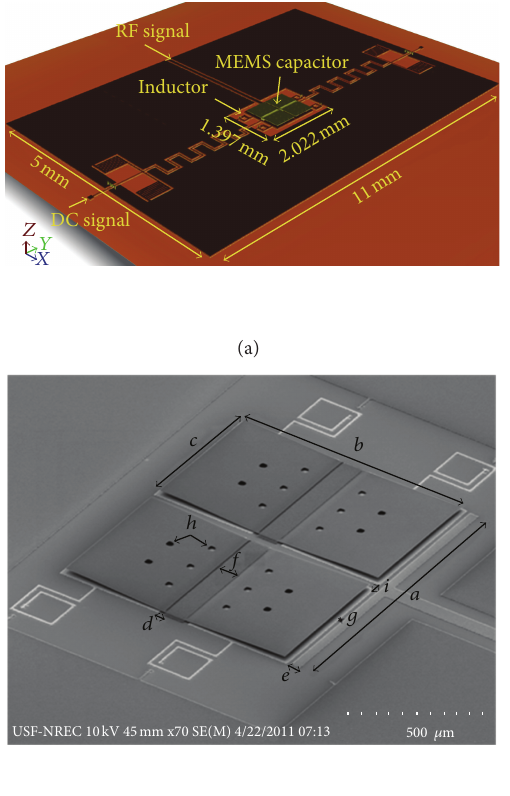
F 2: (a) MEMS-MTM antenna in CoventorWare and (b) details of a MEMS-MTM CRLH-TL basic cell of the fabricated